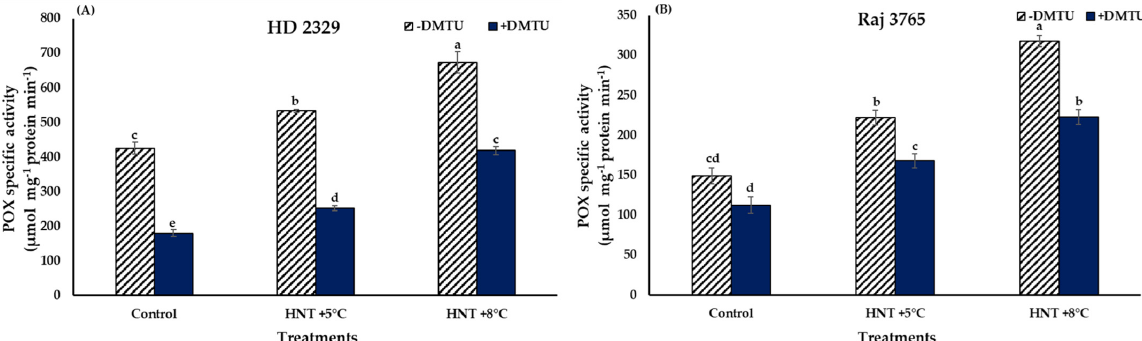
Figure 8. Effect of HNT on peroxidase specific activity in pistil of wheat genotypes ( A ) HD 2329 (sensitive) and ( B ) Raj 3765 (tolerant) under control, HNT (+5 °C) and HNT (+8 °C) conditions in absence and presence of ROS scavenger (DMTU). Bars represent mean ± SE. Bars with common letter are not significantly different between temperature treatments in a genotype at p < 0.05.